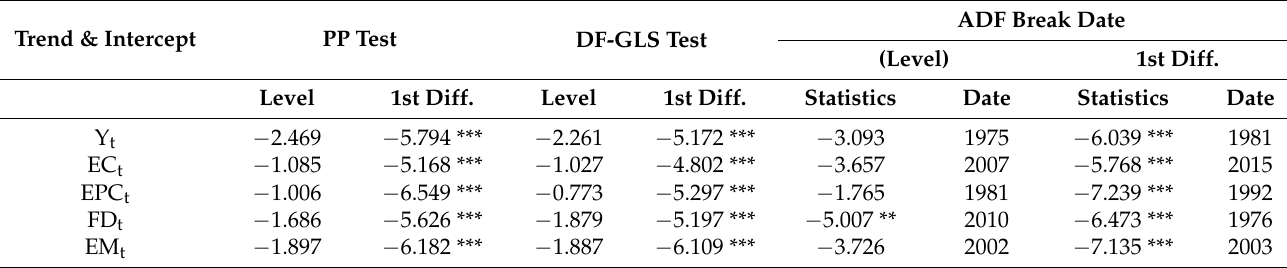
Table 2. Structural break unit root test.